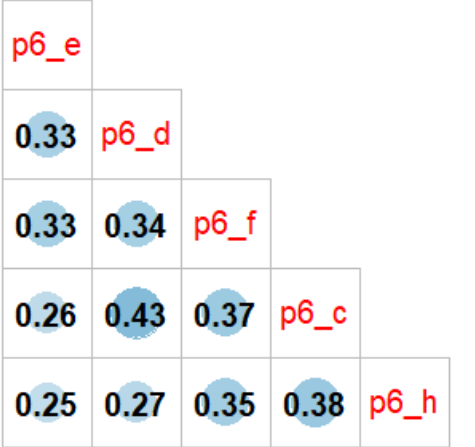
Figure 3. Correlations between the methodologies used to learn social sciences.